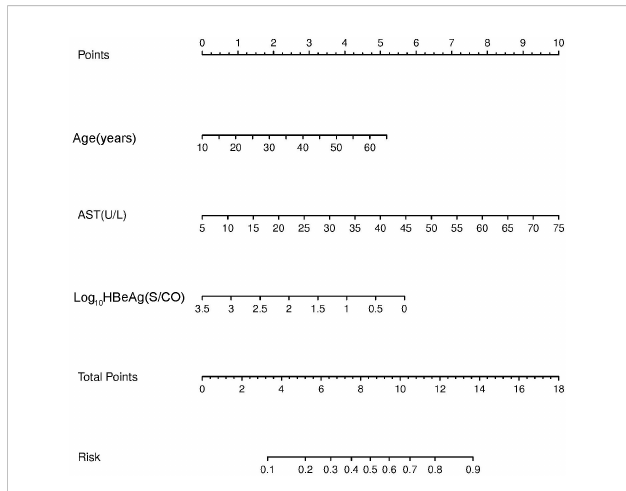
FIGURE 1 Non-minimal liver in fl ammation nomogram for hepatitis B e antigen (HBeAg)-positive chronic hepatitis B (CHB) patients with alanine aminotransferase (ALT) <80 U/L.